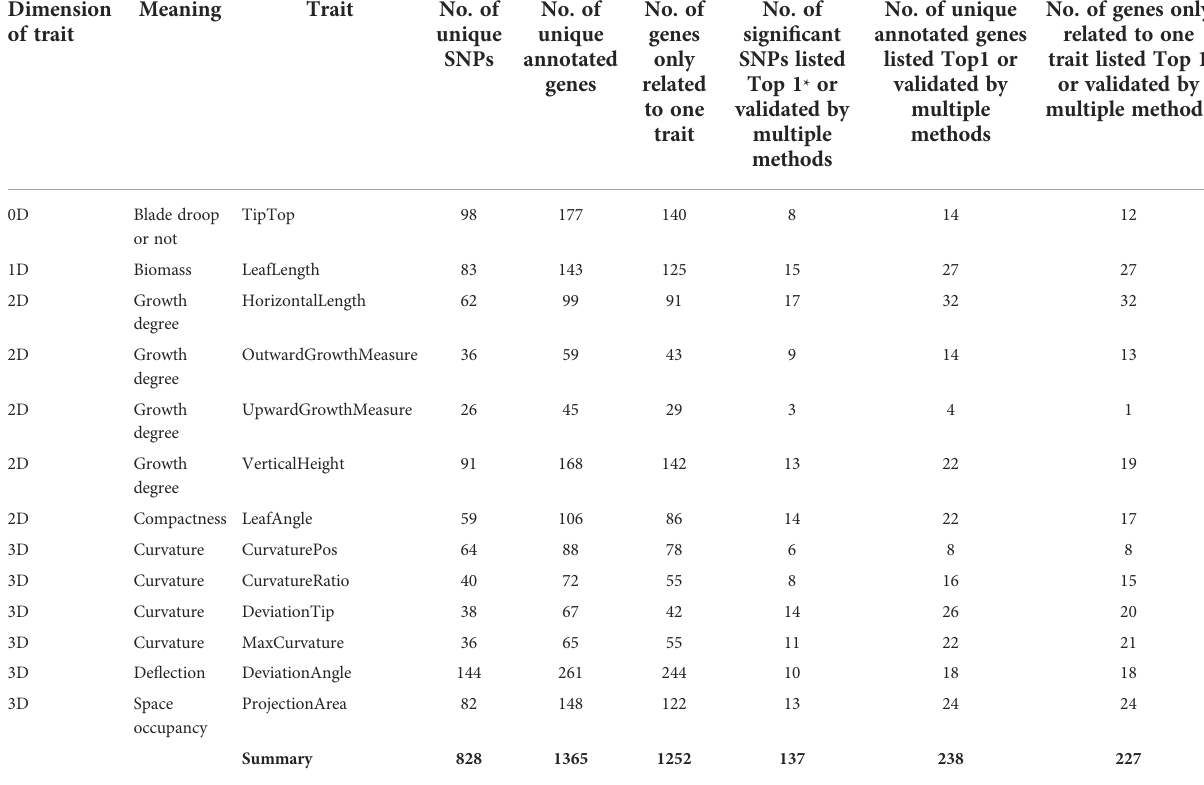
TABLE 2 Summary of signi fi cant SNPs and candidate genes from GWAS (*Top1, the most signi fi cant SNP obtained by each GWAS method.). Dimension of